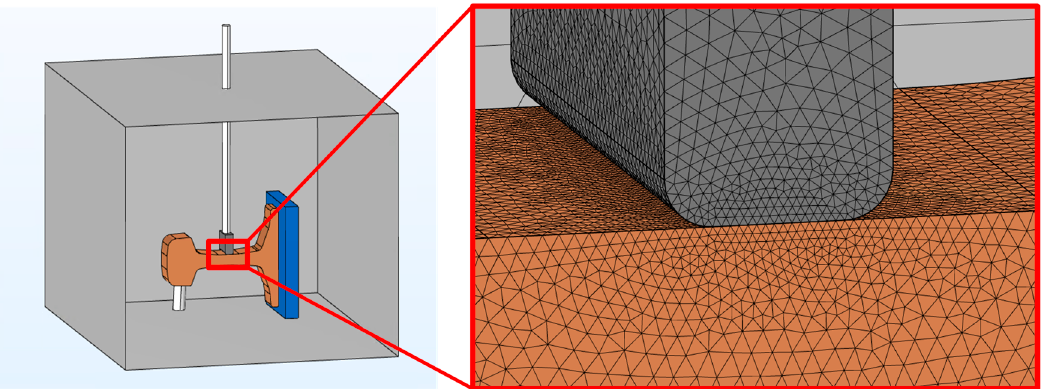
Figure 11. Isotherms and heat flow are displayed in the cross-section of the heating rod and rail from a previous calculation.